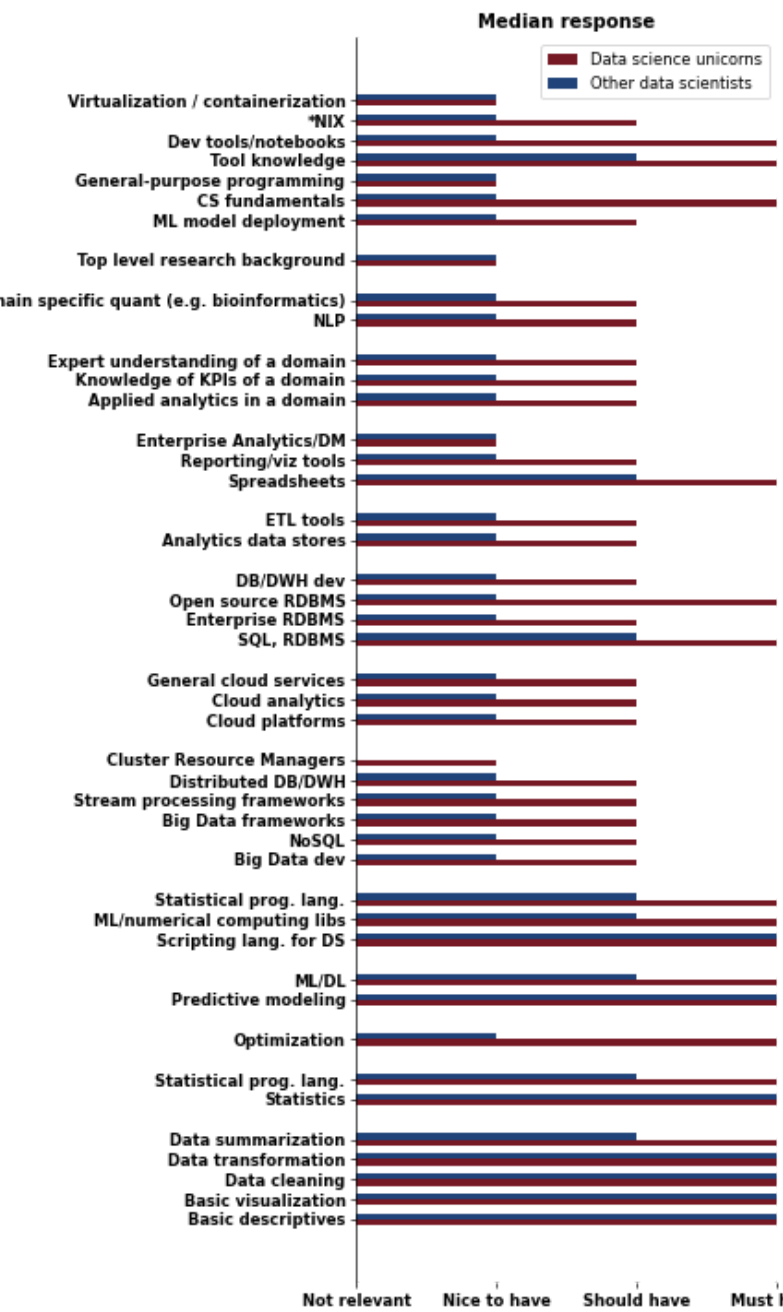
Figure 2. Median responses of the identified data science unicorns to the questionnaire items in comparison with the rest of self-declared data scientists. Questionnaire items are grouped for clarity, and they are labeled with short explanations for brevity. See Appendix D for an explination of all abbreviations The individual responses by the identified data science unicorns, along with a summary of their responses collectively, are depicted in Figure 3.